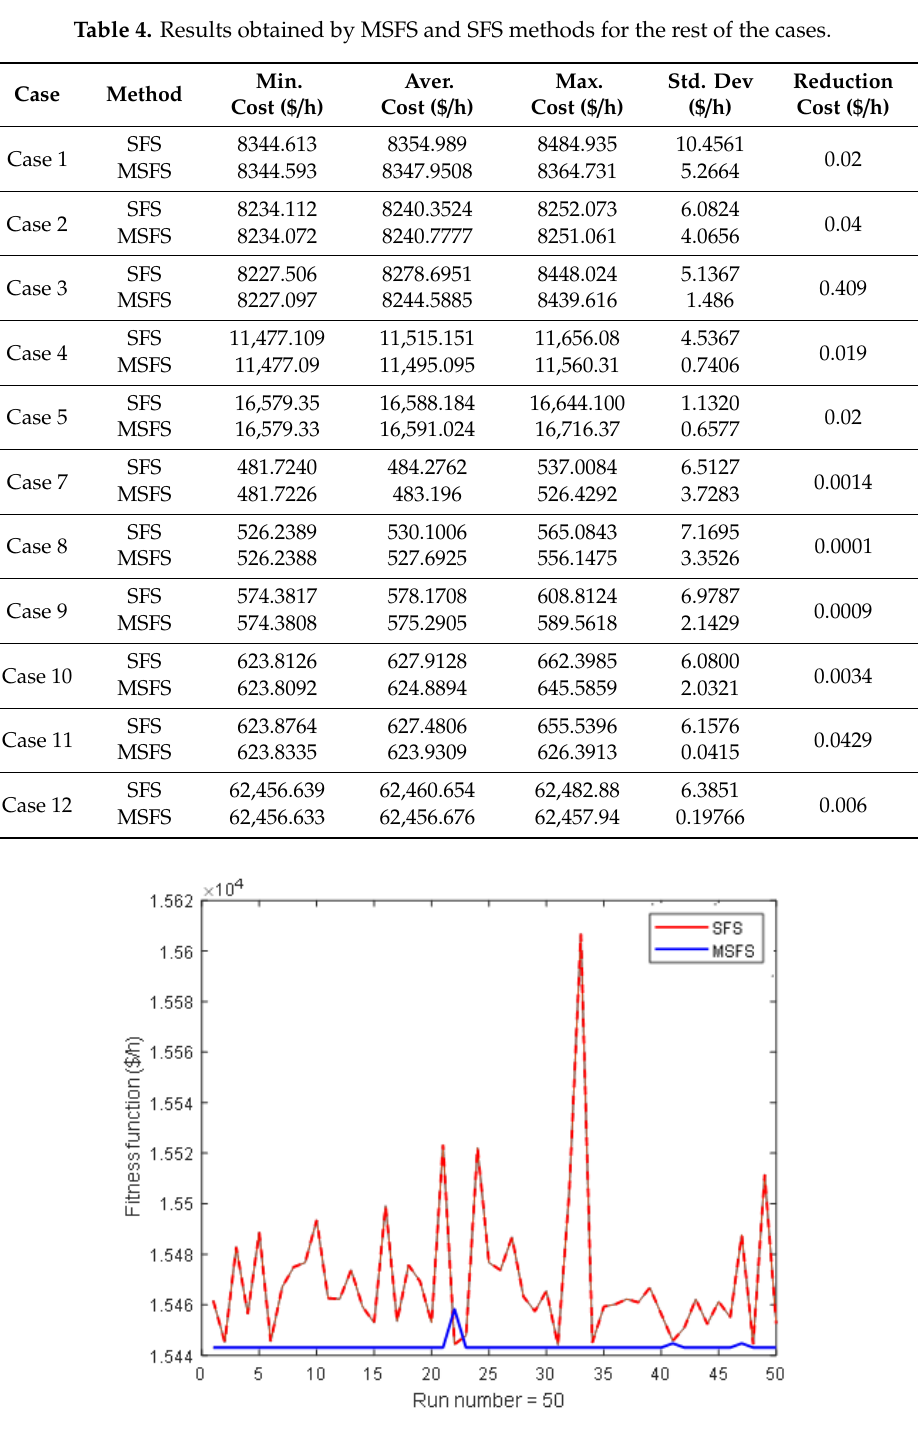
Figure 7. Distribution of 50 runs obtained by SFS and MSFS for case 6.